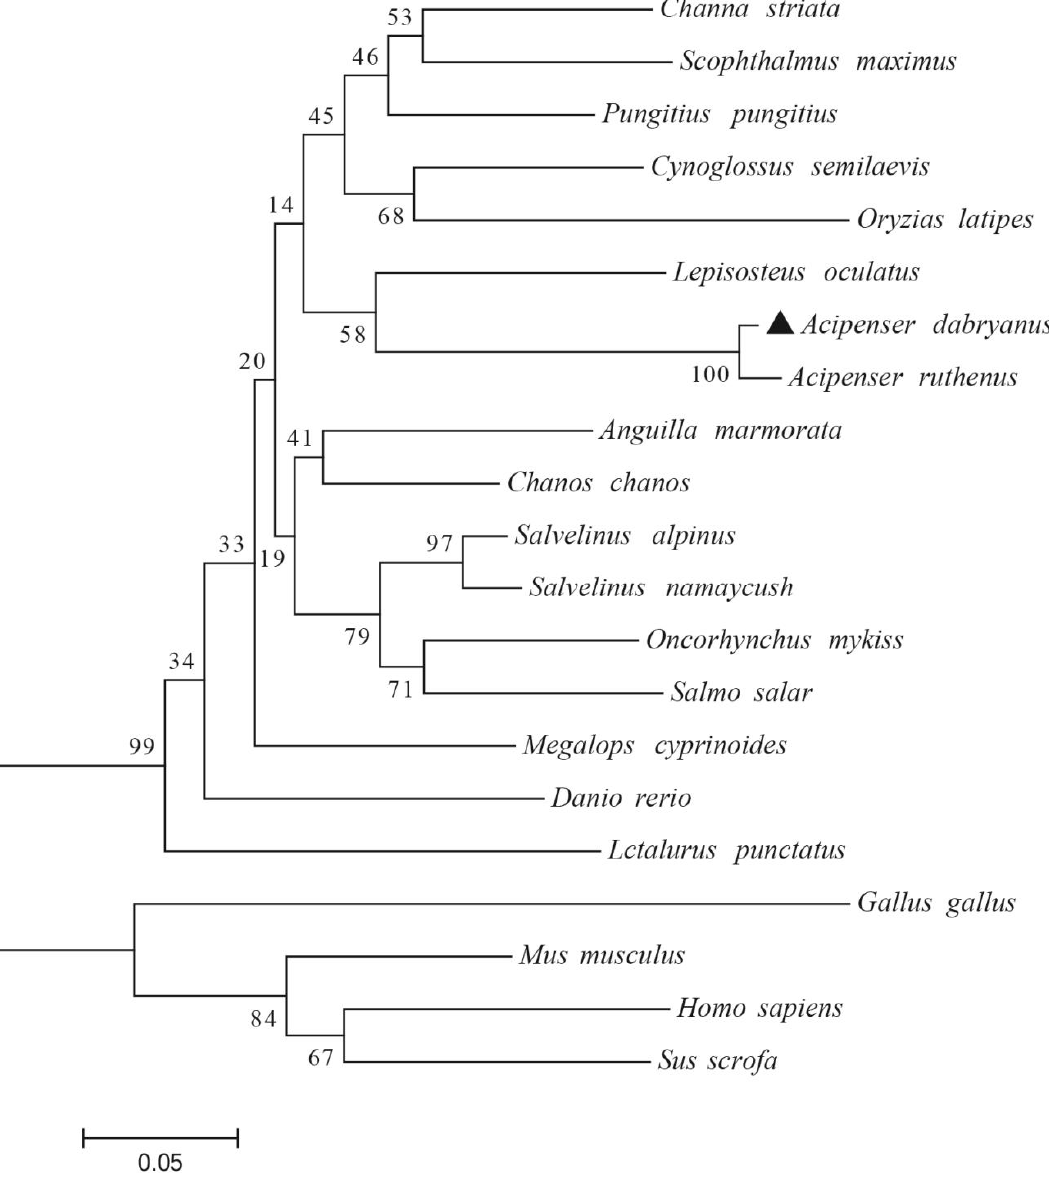
Figure 4. Phylogenetic tree of the amino acid sequence of the AdCu/Zn-SOD protein. (cid:78) was used to highlight Acipenser dabryanus.